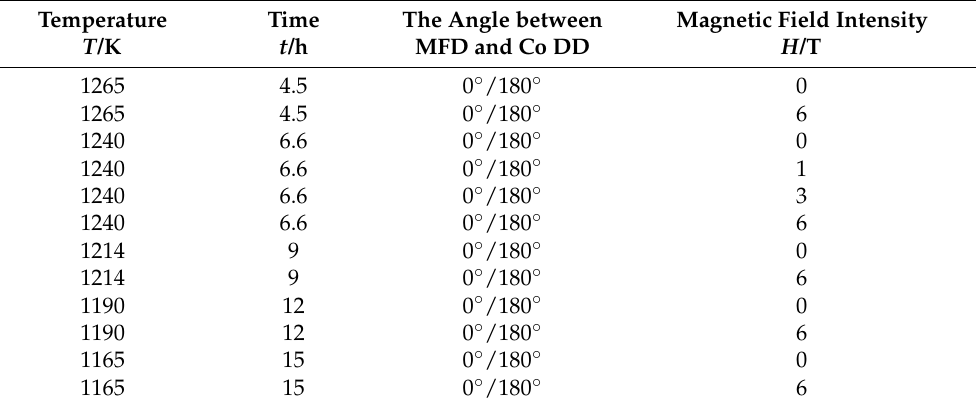
Table 1. Parameters of the magnetic field annealing for copper and cobalt diffusion couple.